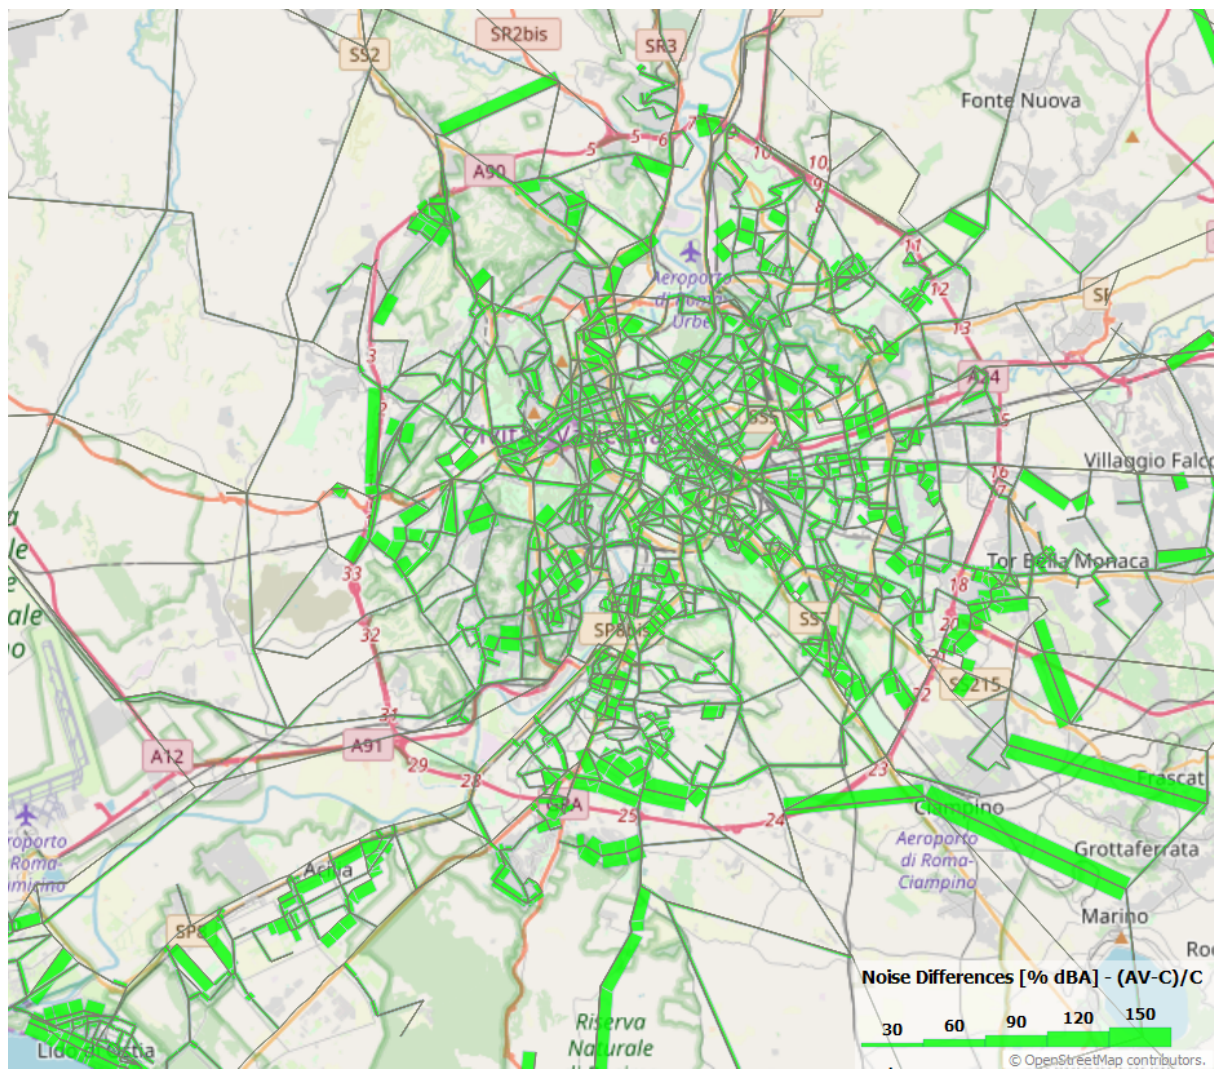
Figure 4: Noise pollution comparison: negative relative difference (100% AVs emissions are lower than current